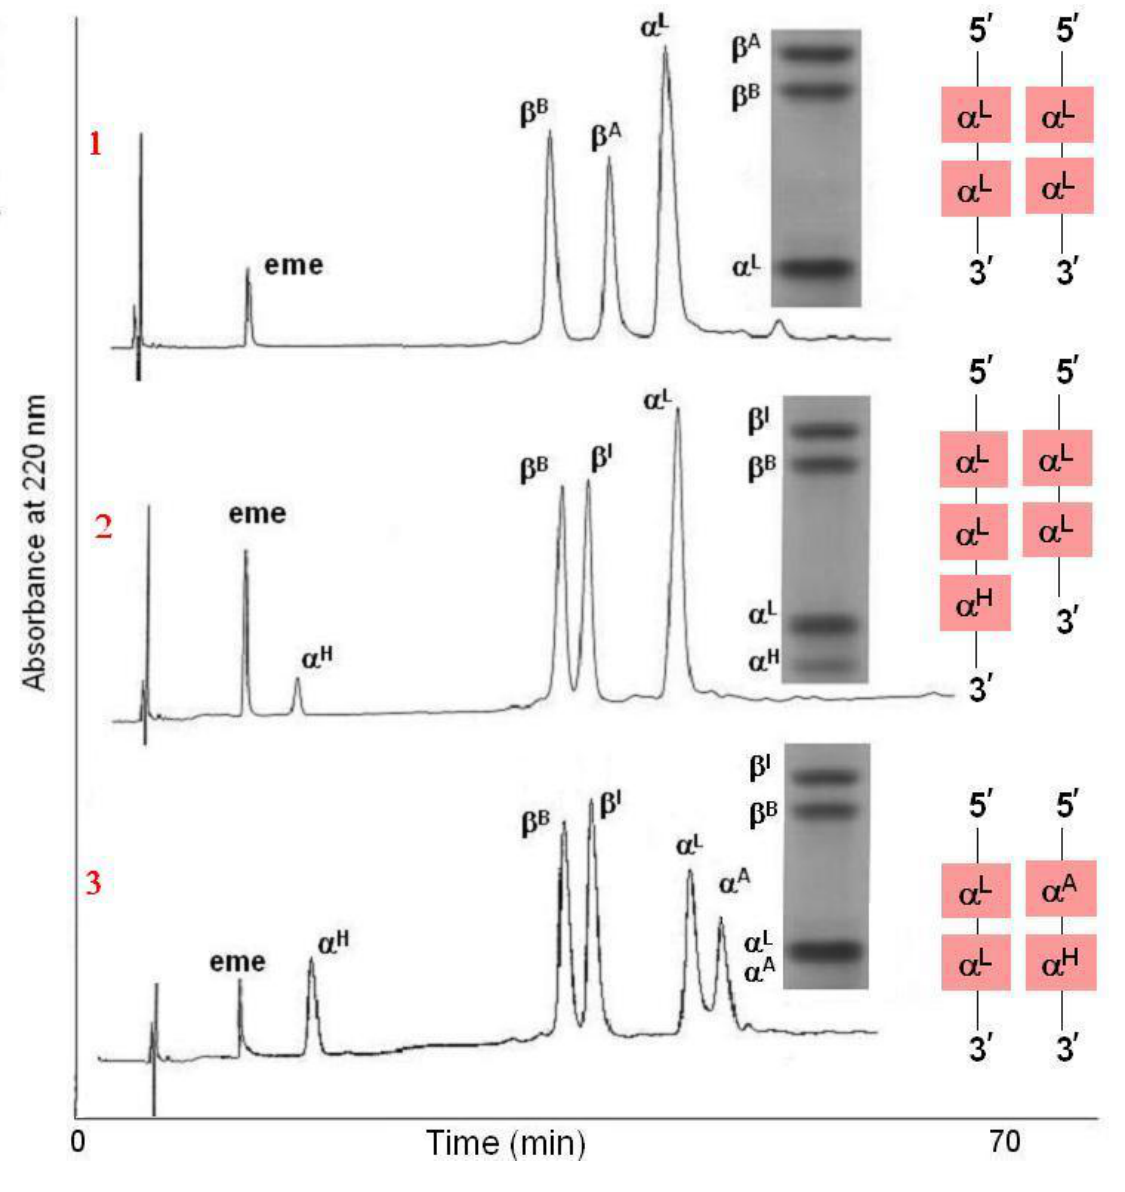
Figure 6. AUT-PAGE and HPLC chromatografic profiles of alpha and beta globin variants in sheep. Panel (1) one alpha globin (α L ) and two allelic beta globins (β A , β B ); in panel (2) two non allelic alpha globins (α H , α L ) and two allelic beta globins (β A , β I ); in panel (3)